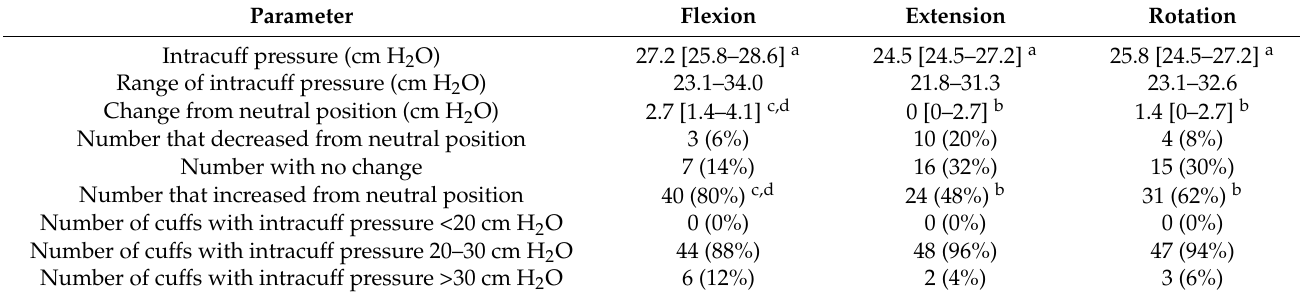
Table 3. Changes in the intracuff pressure with head positioning when the initial value was set as 24.48 cm H 2 O (=18 mmHg) using a pressure monitoring